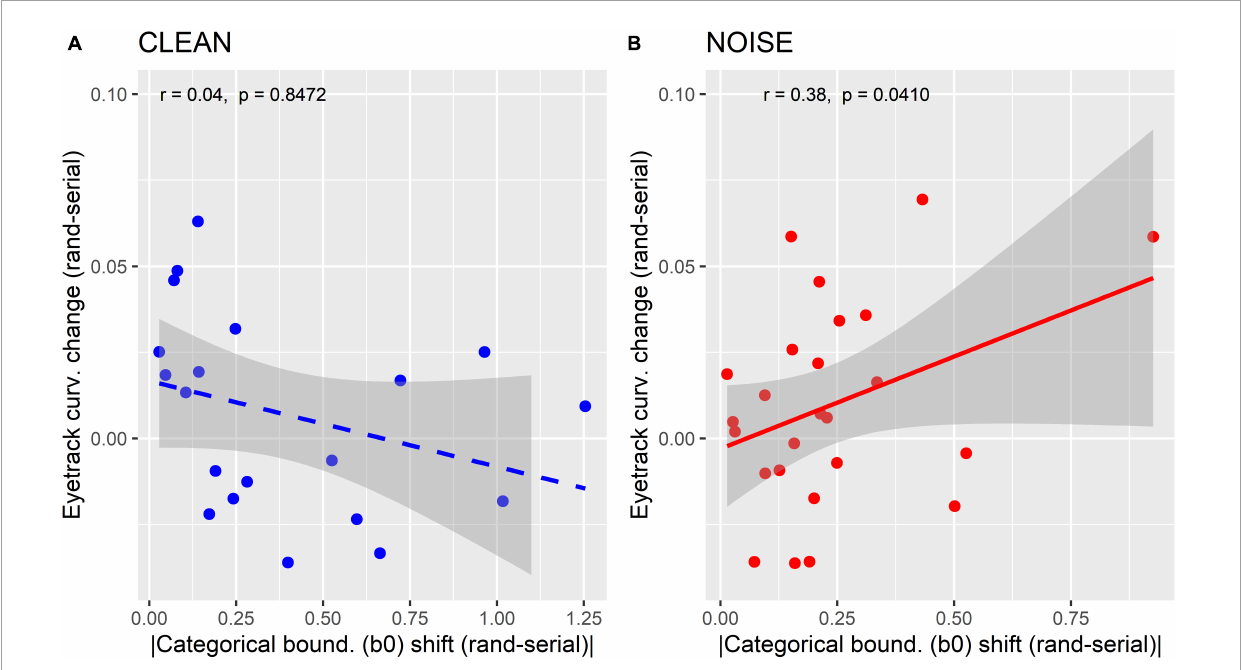
FIGURE5 Correlations between behavioral and mousetracking measures of perceptual warping. (A) Clean condition. (B) Noise condition. Listeners with larger magnitude shifts in their psychometric boundary ( β 0) between random and serial token orders (indictive of stronger perceptual warping) show more salient change in the trajectory of their mousetracks. Mouse trajectories show straighter trajectories to the ultimate behavioral response under serial order. This brain-behavior relation is only observed for noise-degraded speech. Solid line = significant correlation; dashed line = n.s.; Shaded regions = 95%